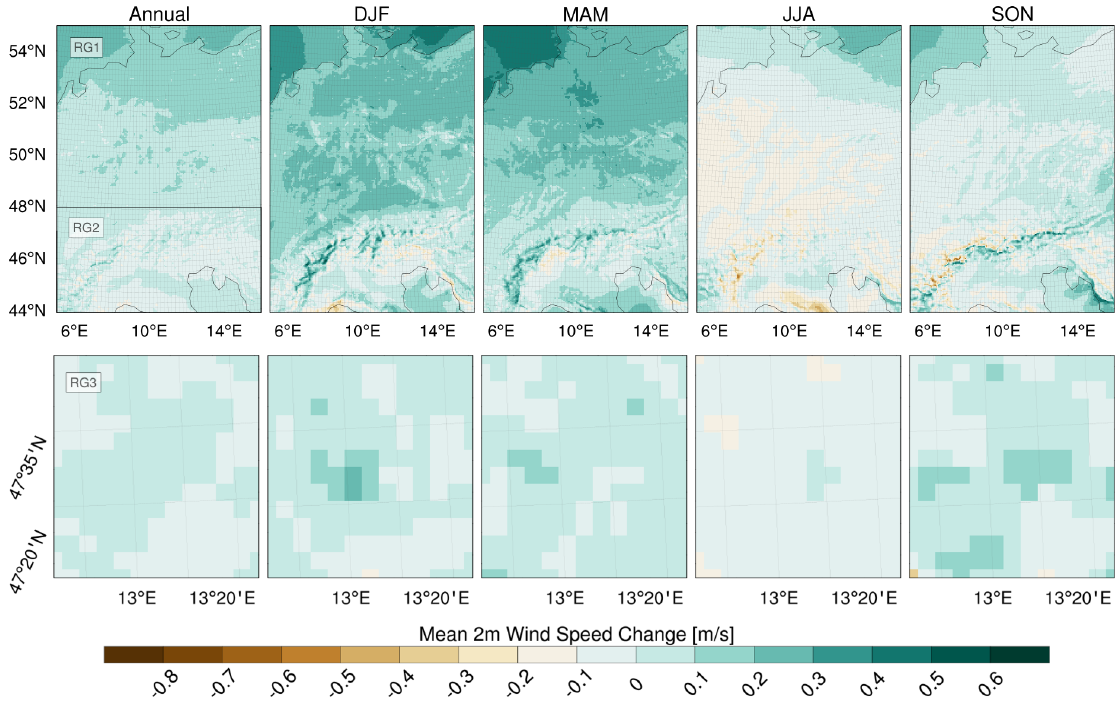
Figure 17. Projected changes 2020–2049 (scenario RCP4.5) compared to 1980–2009 for wind speed for RG1, RG2 (top row), and RG3 (bottom row). Annual, winter (DJF), spring (MAM), summer (JJA), and fall (SON) changes are displayed (from left to